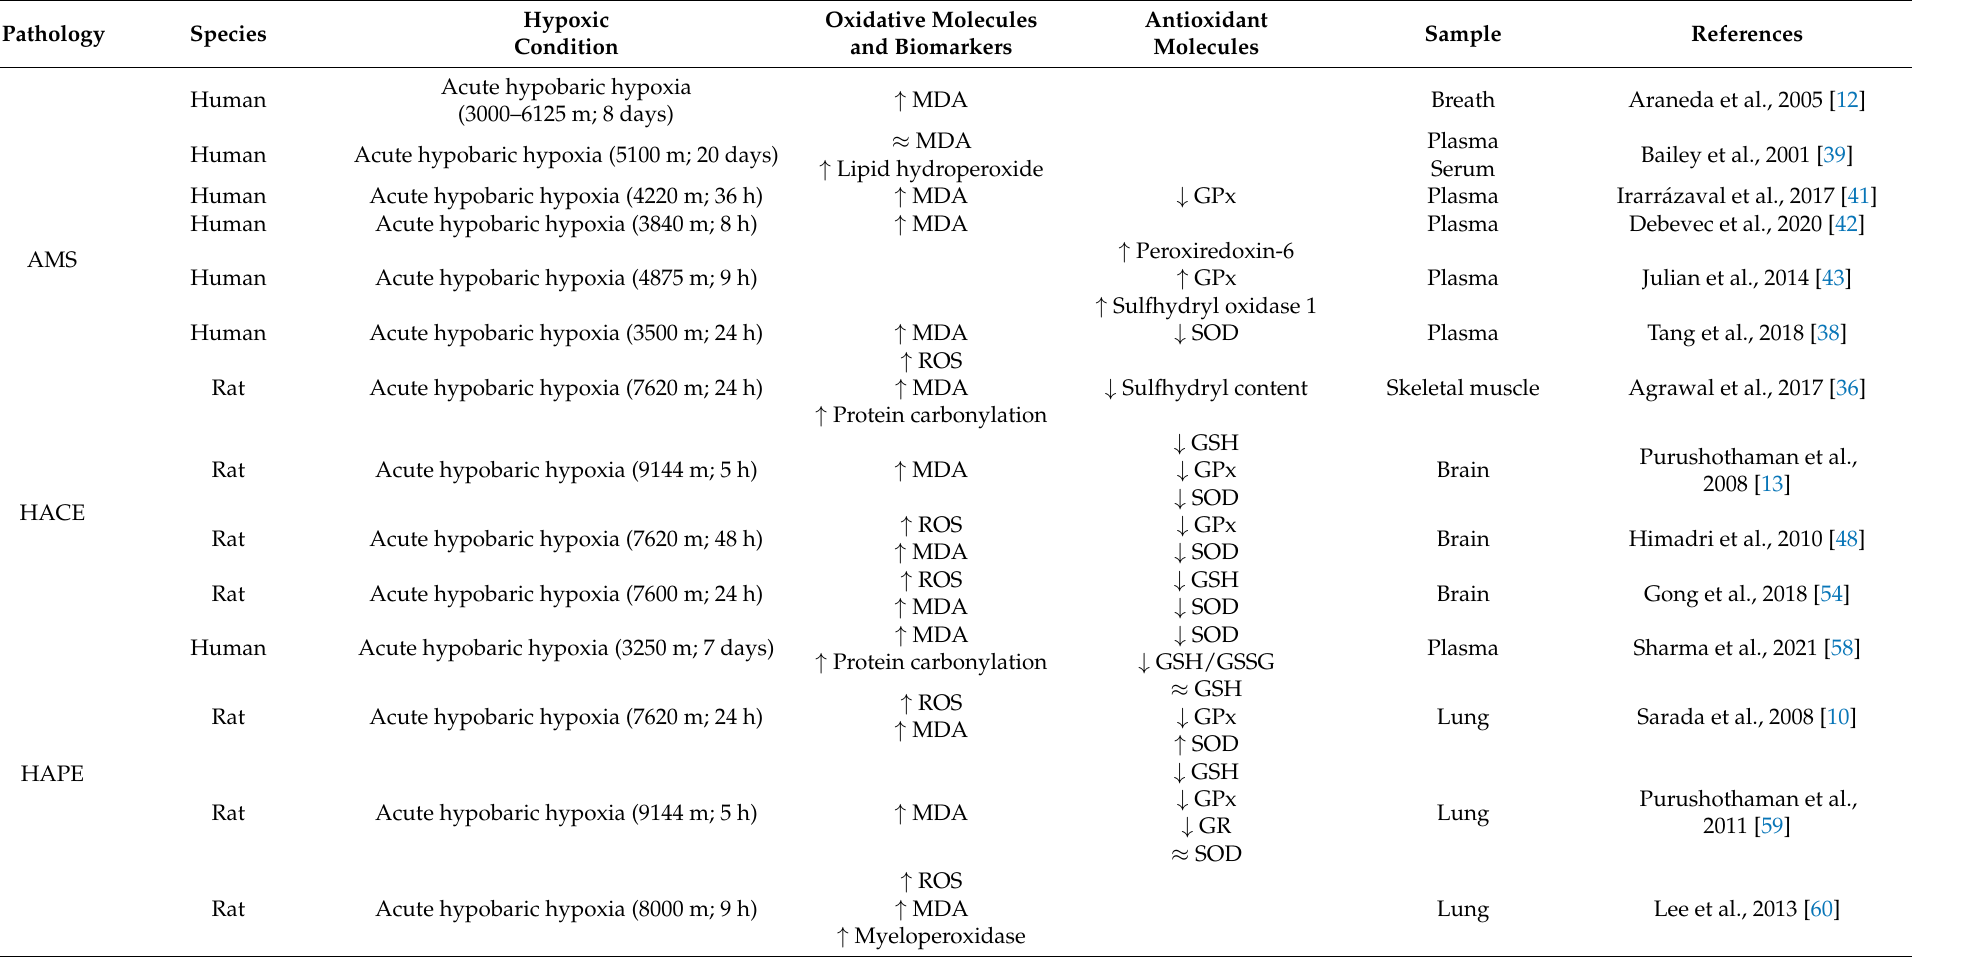
Table 1. Oxidative stress and antioxidants in high-altitude